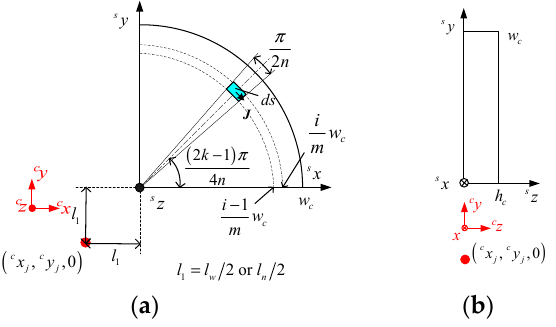
Figure 4. Corner segment model. ( a ) Top view of the division of the corner segment; ( b ) Left view of the division of the corner segment. The corner segment is divided into n fan-shaped sectors and m sectors in the direction of the axis of s x .